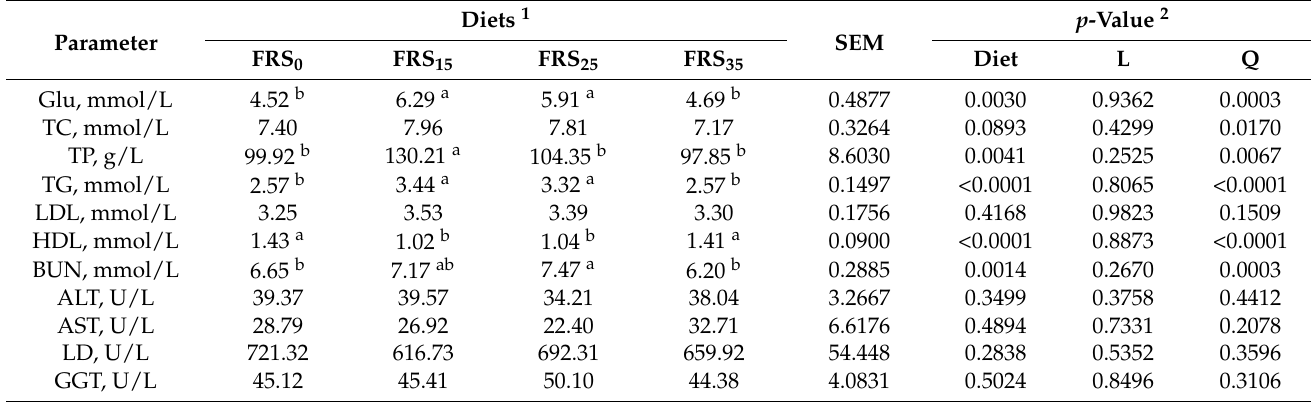
Table 6. Blood parameters in lactating buffaloes fed the four experimental